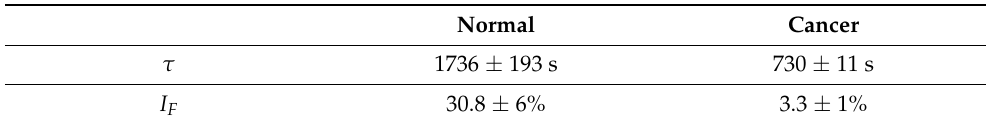
Table 1. The recovery time τ and the immobilized fraction I F are different in normal (MCF-12A) and cancer (MDA-MB-231)